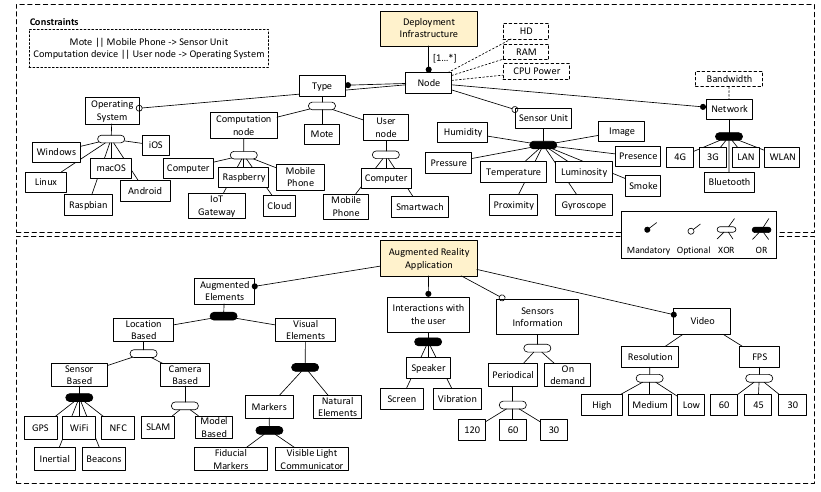
Figure 2. Feature models of a DI and a family of AR